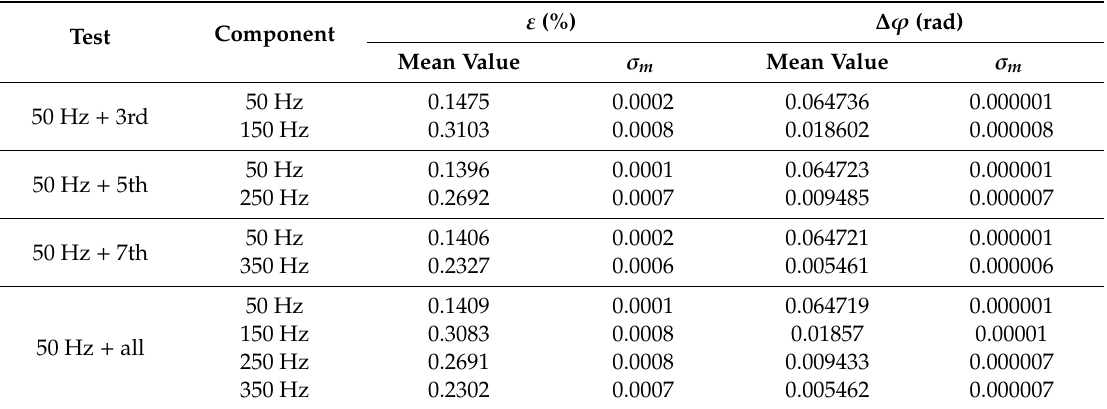
Table 4. Experimental DW test